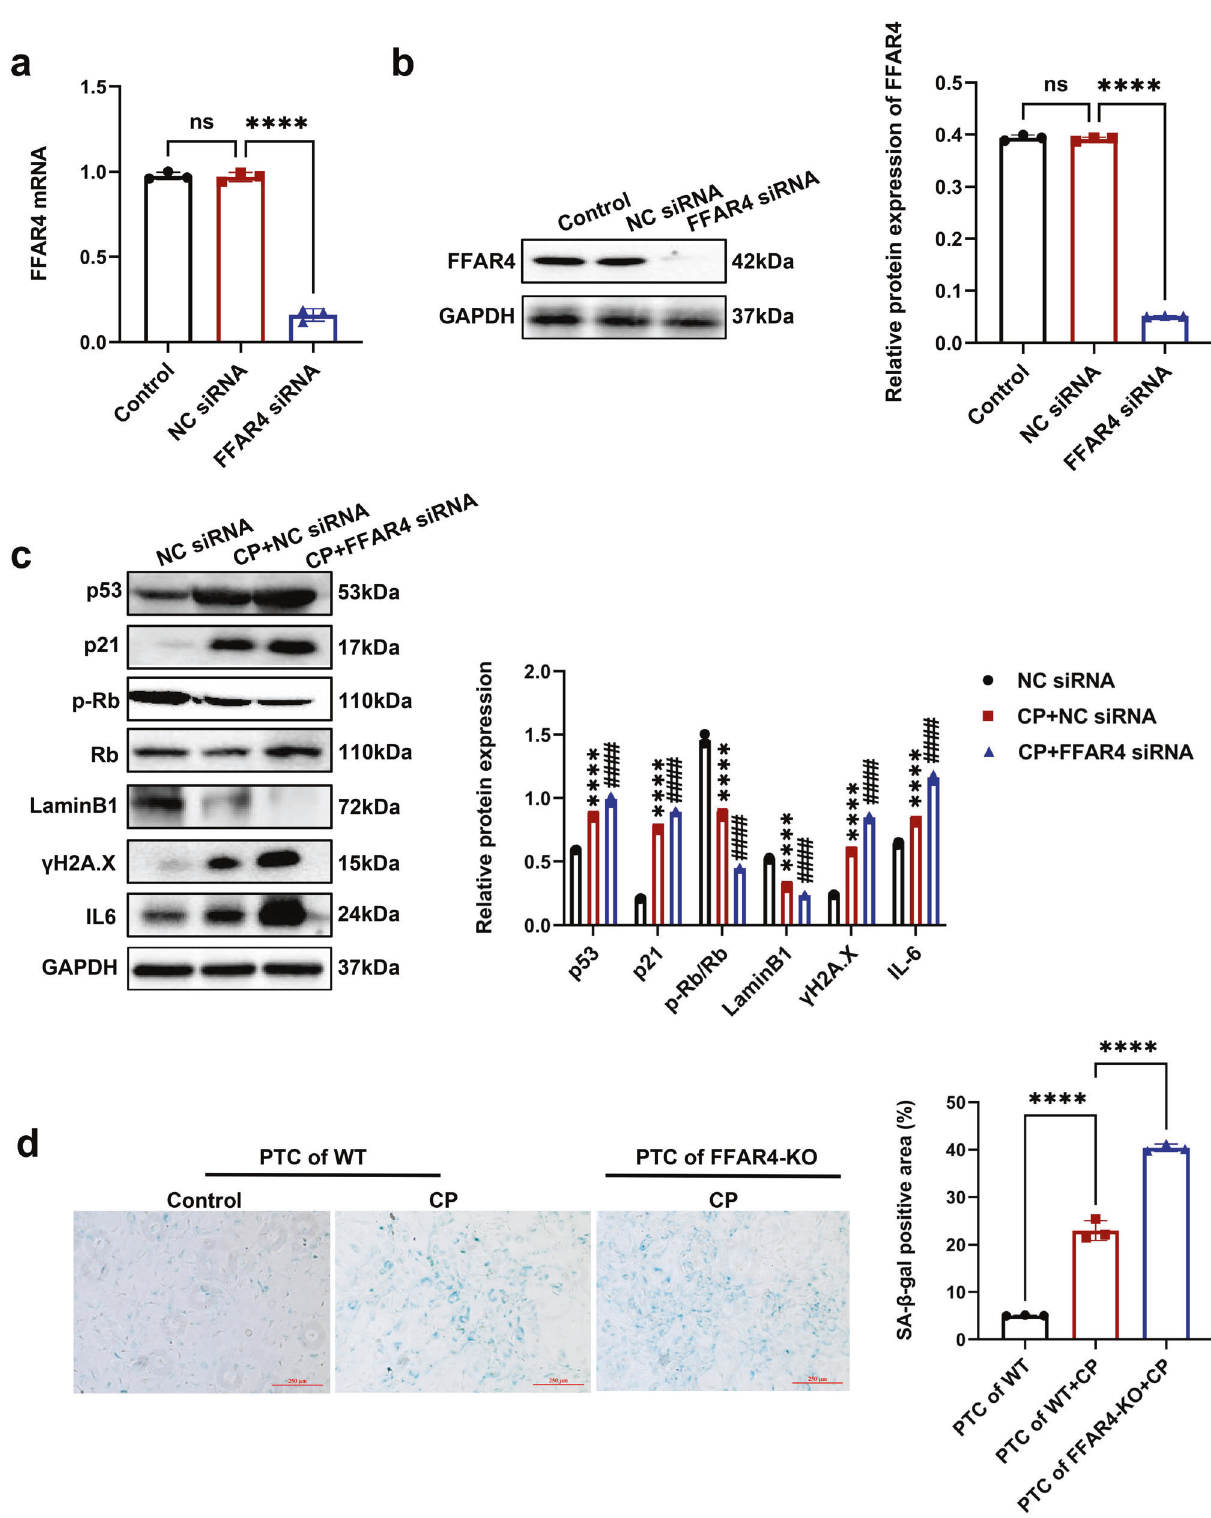
Fig. 6 Inhibition of FFAR4 aggravated cellular senescence in cisplatin-stimulated renal tubular epithelial cells. a , b TCMK-1 cells were transfected with negative control (NC) siRNA or FFAR4 siRNA for 24 h and then treated with 2 μ g/ml cisplatin for 6 h. The knockdown ef fi ciency of FFAR4 siRNA in TCMK-1 cells was evaluated by quantitative real-time PCR analysis and western blot analysis ( n = 3; **** P < 0.0001, ns no signi fi cant). c Protein expression of p53, p21, LaminB1, p-Rb/Rb, ɣ H2A.X and IL-6 detected by western blotting and quanti fi ed by densitometry ( n = 3; **** P < 0.0001, CP + NC siRNA vs . NC siRNA; #### P < 0.0001, CP + FFAR4 siRNA vs. CP + NC siRNA). d Representative images and quantitative analysis of SA- β -gal staining of renal primary tubular cells (PTCs) from WT and FFAR4-KO mice (100×, scale bar = 250 μ m) ( n = 3; **** P < 0.0001). Data are presented as mean ± SD. CP